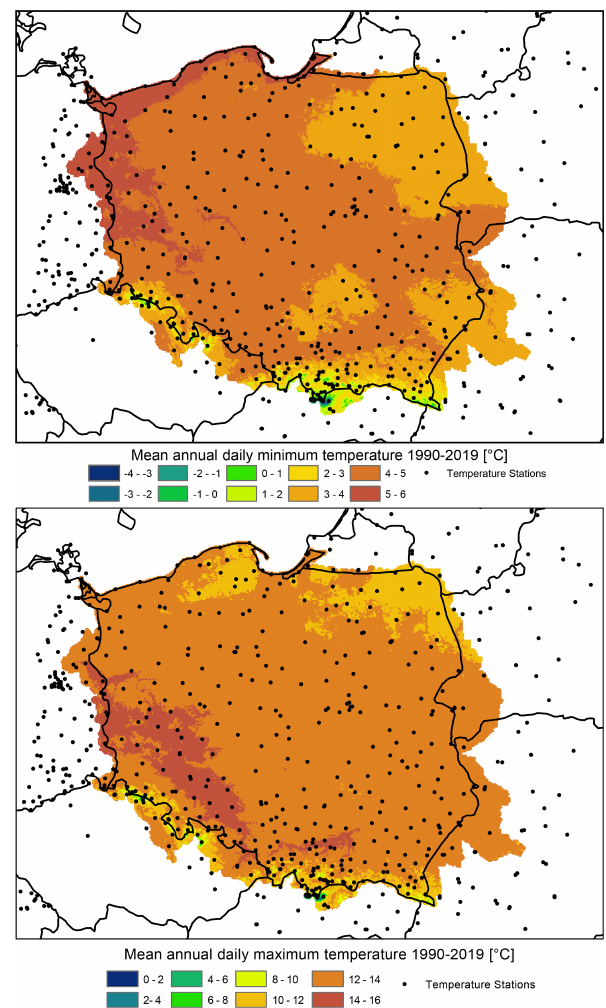
Figure 21. Mean annual daily minimum and maximum temperature in the time period 1990–2019: output from the G2DC-PL +